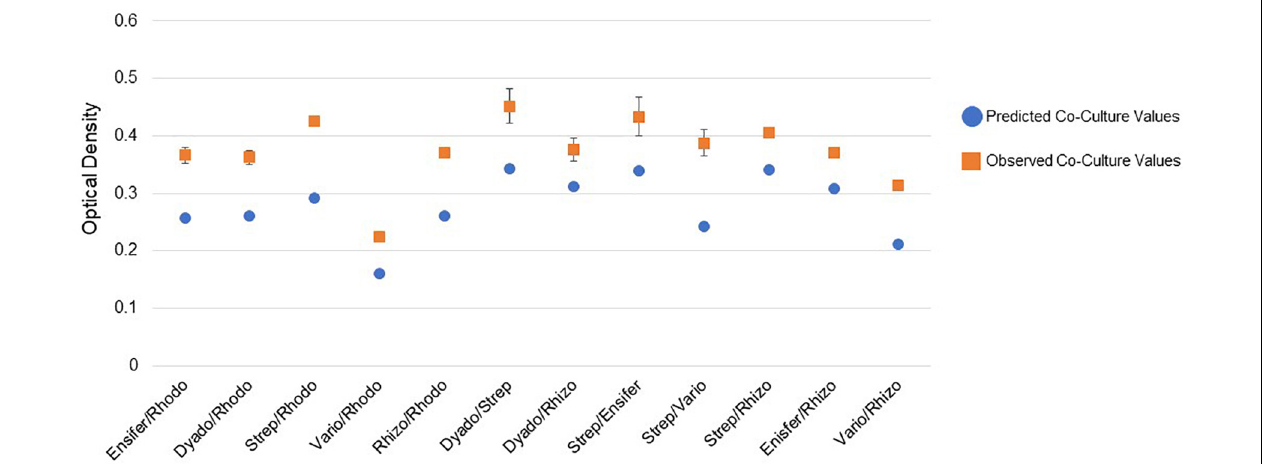
FIGURE 7 | Pairwise interactions of MSC-1 isolates during growth on N-acetyl-glucosamine (NAG). Pairwise combinations of species are shown on the x-axis (Rhodo-Rhodococcus; Dyado-Dyadobacter; Strep-Streptomyces; Vario-Variovorax; Rhizo-Rhizobium). Optical density (OD 600) is shown on the y-axis and represents OD collected during early exponential phase of growth. Blue circles represent predicted co-culture values, orange squares represent observed co-culture values.